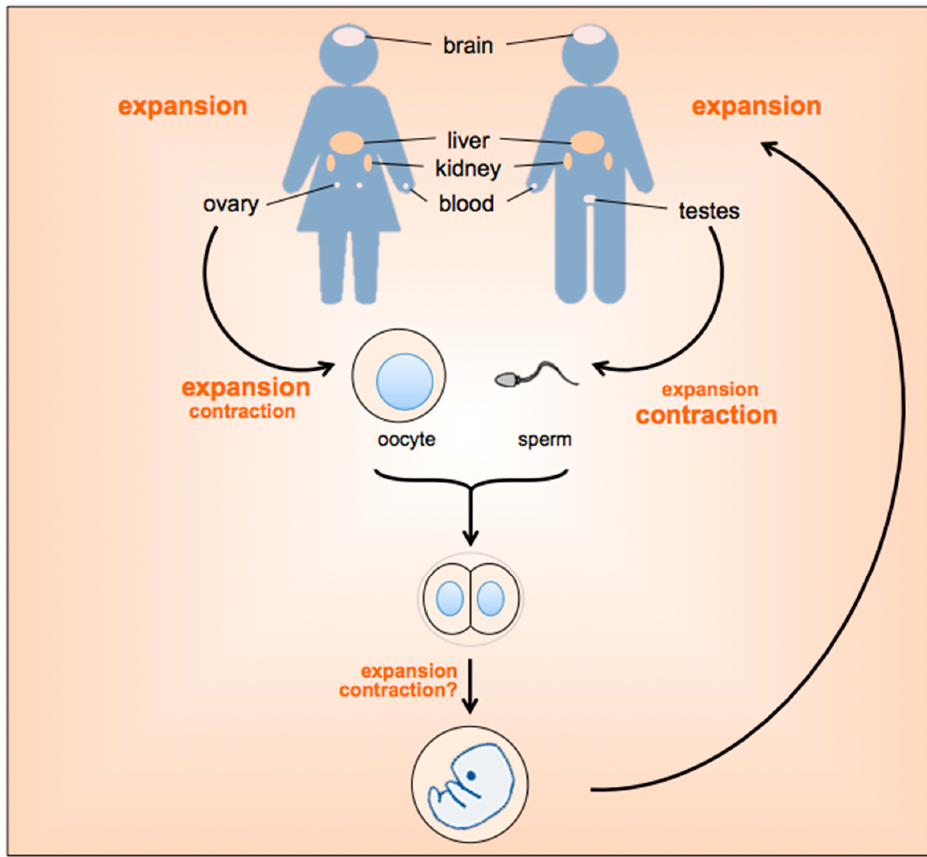
Figure 1. Timing and tissue distribution of expansions in the Fragile X ‐ related disorders (FXDs). The data for this figure reflects a synthesis of data from humans and a mouse model of the Fragile X premutation (FX PM). Intergenerational expansions likely occur prezygotically and perhaps in the very early embryo. Both maternal and paternal expansions are observed. However, as the repeat number increases so the frequency of paternally transmitted contractions increases [19]. In contrast, expansions that generate larger alleles predominate in females, with the likelihood that a PM allele will be transformed into a full mutation (FM) allele reaching 100% as the repeat number approaches 90 [19]. In humans, somatic expansions have been observed in blood and brain. Work in the FX PM mouse suggests that expansions can also occur in organs like liver and kidney, with more somatic expansions being observed in males than females. No contractions have been seen in the somatic tissue of adult animals. The extent of expansion and contraction is indicated by the font size of the associated text.